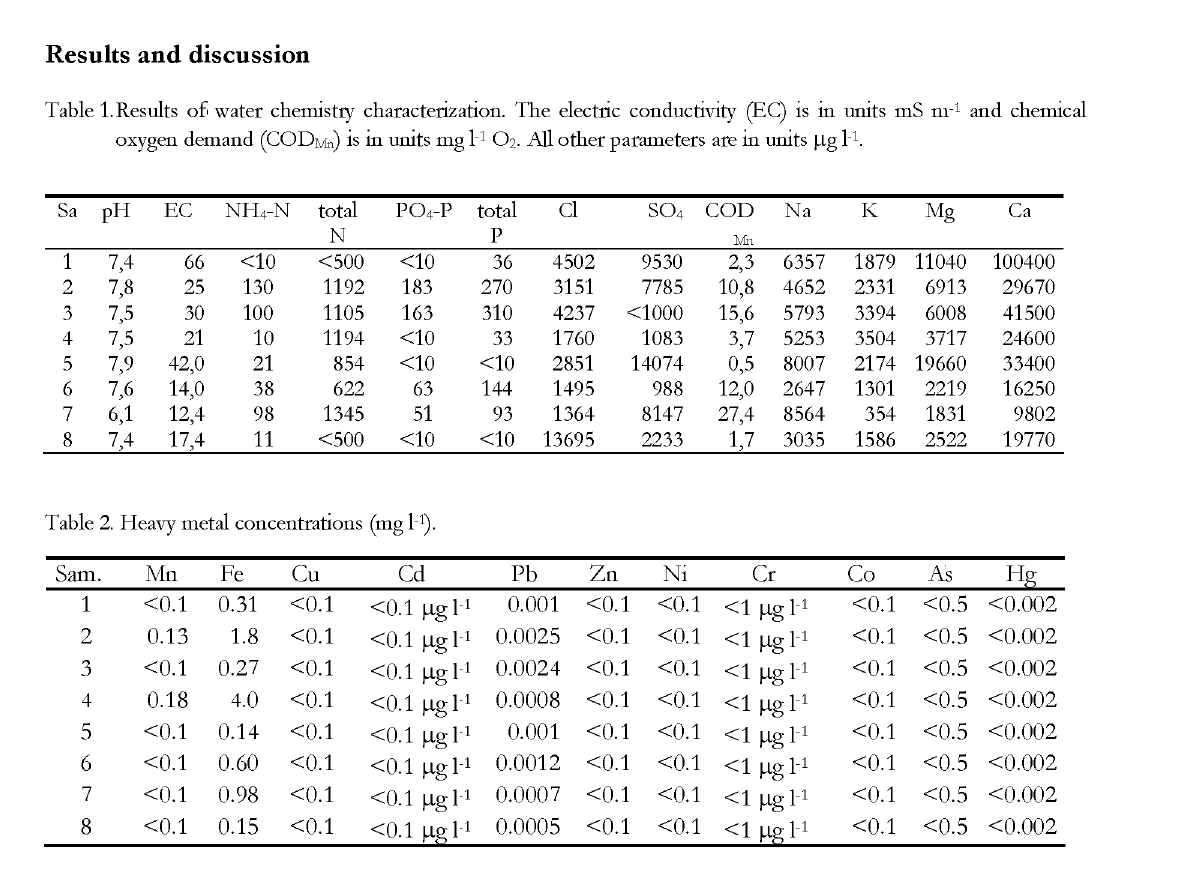
Table 1. Results of water chemistry characterization. The electric conductivity (EC) is in units mS nr 1 and chemical